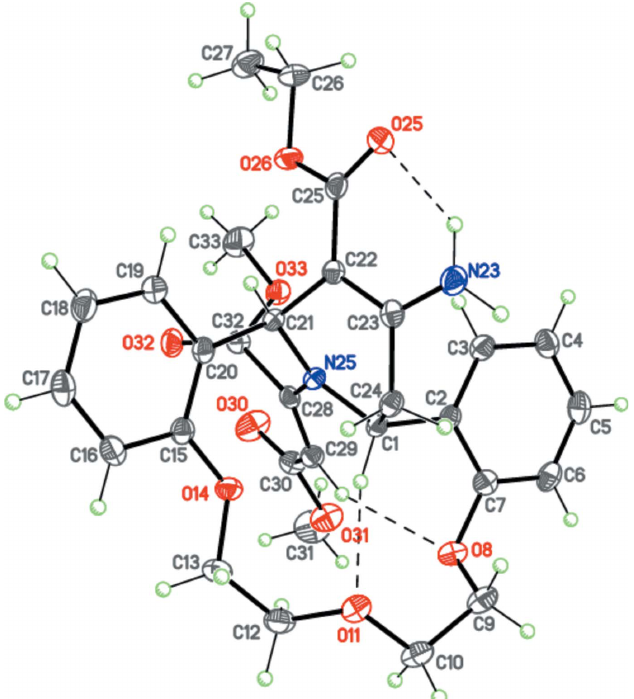
Figure 2 The molecular structure of 4 . Displacement ellipsoids are shown at the 50% probability level. H atoms are presented as small spheres of arbitrary radius. Dashed lines indicate the intramolecular N—H (cid:3)(cid:3)(cid:3) O and C—H (cid:3)(cid:3)(cid:3) O hydrogen bonds.